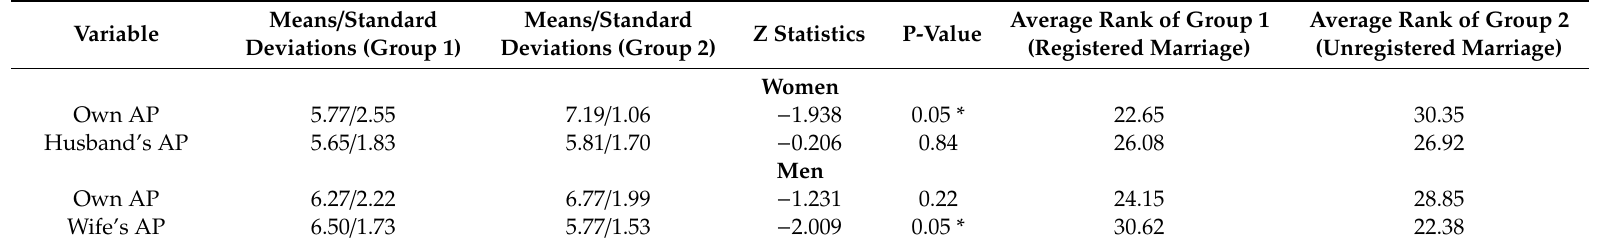
Table 3. Results of a comparative analysis partner at spouses being in registered and unregistered marriages.